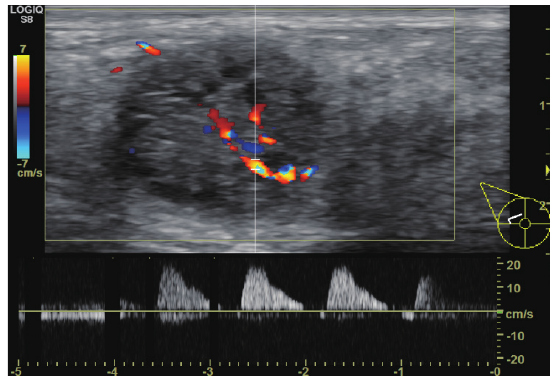
Figure 2 Color Doppler flow imaging revealed a high-impedance pulsatile signal within the tumor.